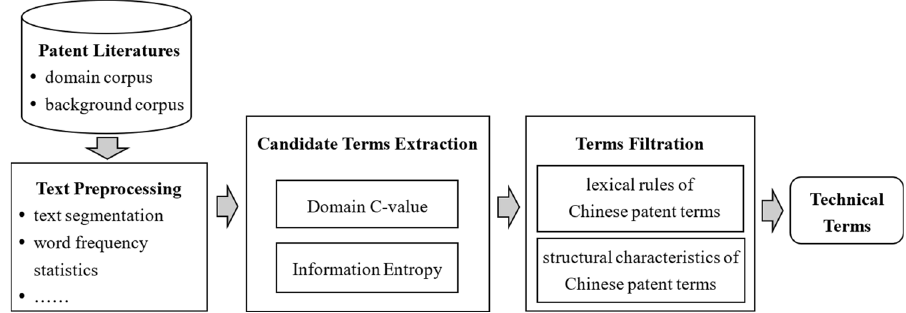
Figure 1. Technical terminology extraction framework of Chinese